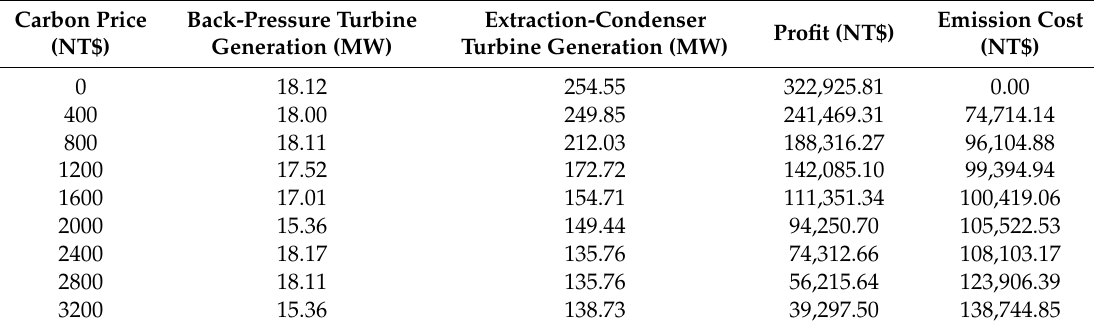
Table 10. The impact of various carbon prices during the peak